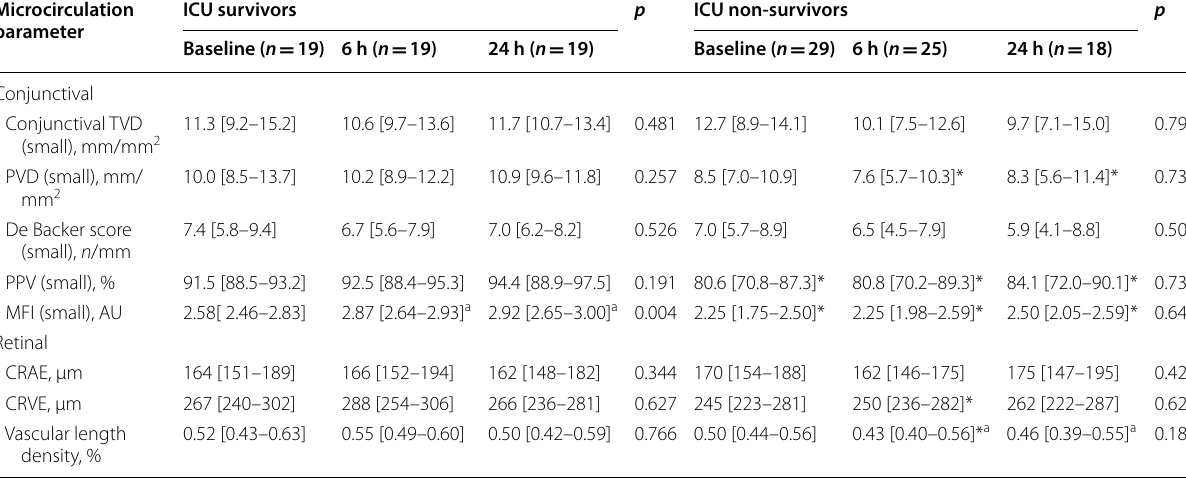
Data are presented as median [IQR] TVD total vascular density, PVD perfused vascular density, PPV proportion of perfused vessels, MFI microcirculatory flow index, CRAE central retinal arteriolar equivalent, CRVE central retinal venular equivalent * p < 0.05 between survivors and non-survivors; a p < 0.05 in comparison with